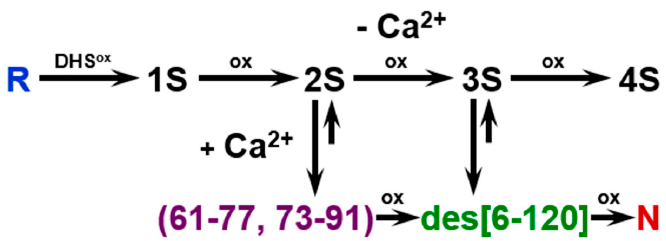
Figure 10. Oxidative folding pathways of α LA by using DHS ox . R and N indicate the reduced and native forms of α LA, respectively. 1S, 2S, 3S and 4S are ensembles of intermediates with the indicated number of SS bonds. The SS bonds of the characteristic 2SS intermediate are shown in parentheses and the missing SS bond of the characteristic 3SS intermediate is shown in brackets with a prefix des.